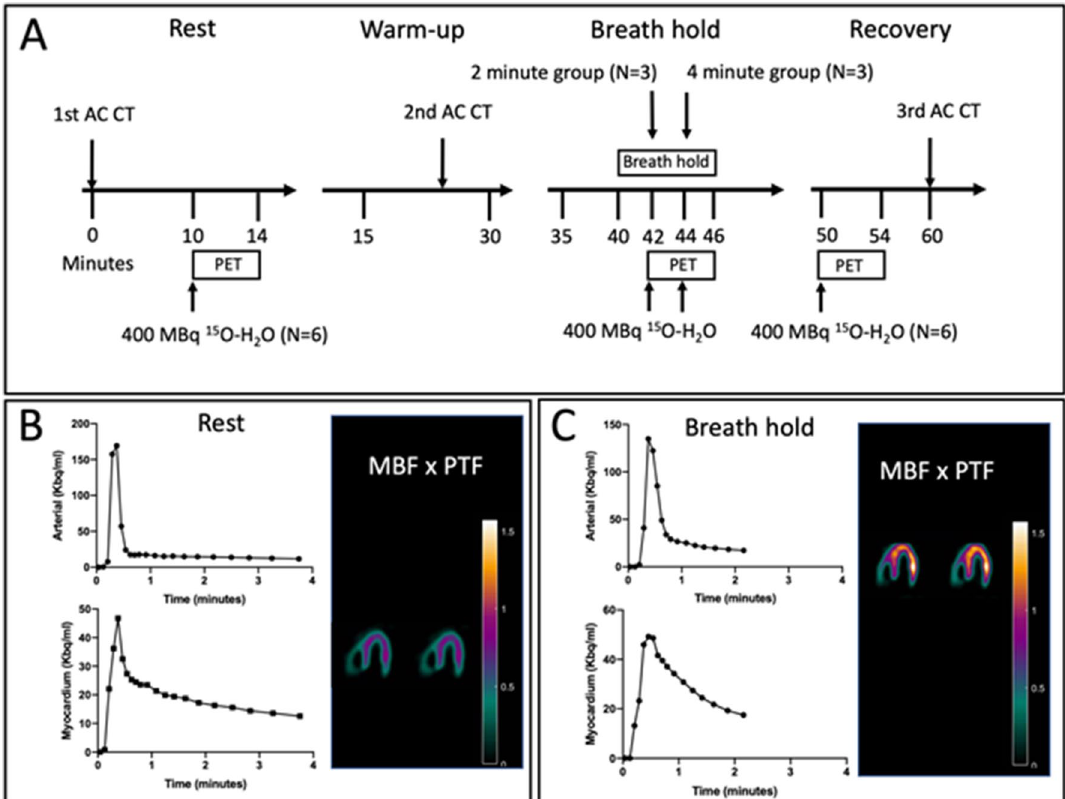
Figure 1. ( A ) 15 O-H 2 O-PET/CT study day flowchart. The resting and recovery perfusion 15 O-H 2 O-PET/CT scans were performed in all participants, whereas the apnea perfusion 15 O-H 2 O-PET/CT was performed with participants divided into two groups with radiotracer bolus injected at 2- and 4-min after initiation of apnea. The average breath hold of all participants were 378 ± 77 s. ( B ) Example of input function (arterial radioactivity, upper row) and myocardial time-activity curves (lower row) in a representative participant. As seen, the entire time-activity curve of the participant has been captured allowing for precise calculation of MBF and PTF. In the right column, horizontal long axis slices with calculation of MBF × PTF allows for parametric visualization of radiotracer uptake in the left ventricle. ( C ) Input function and myocardial time-activity curve for the same subject during apnea. Due to cessation of apnea approximately 2-min after injection of radiotracer (the participant was in the 4-min group), the entire myocardial time-activity curve was not recorded. However, the inflow of tracer was accurately recorded allowing for accurate determination of MBF × PTF, evident from the correct delineation of the left ventricle on the horizontal long axis slices (right side